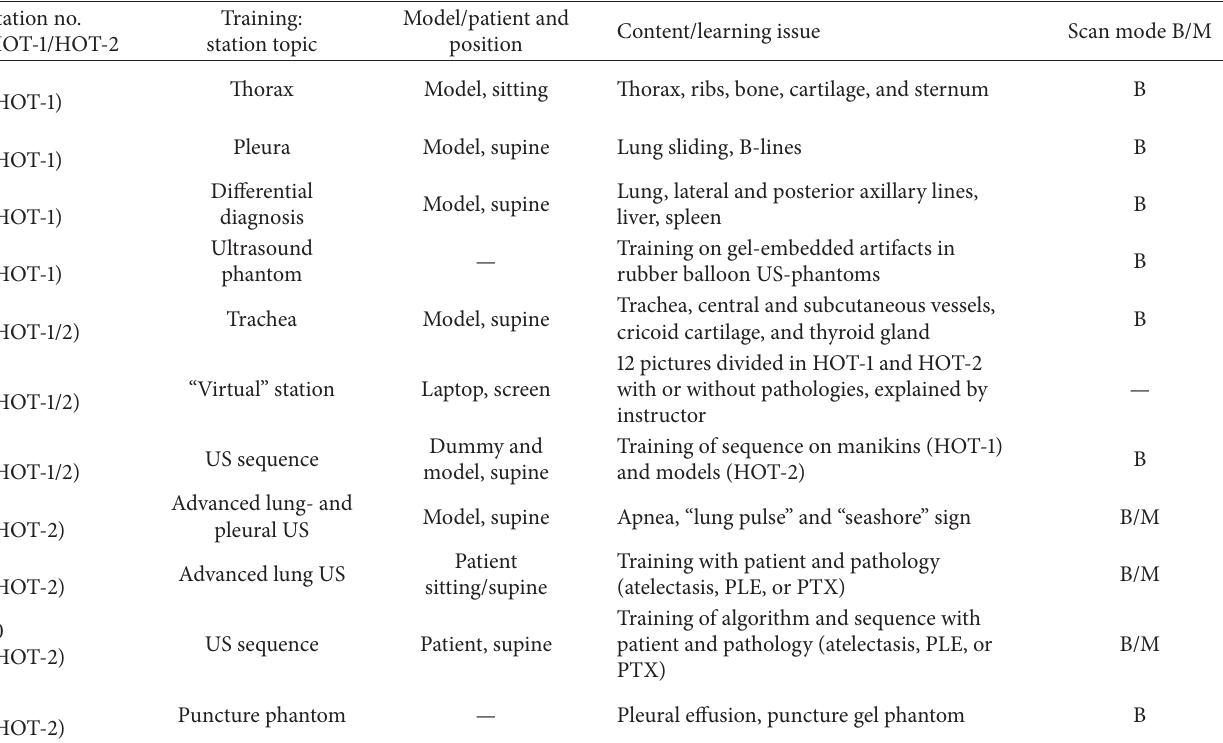
Table 2: Stations and learning targets of hands-on training (HOT) stations.